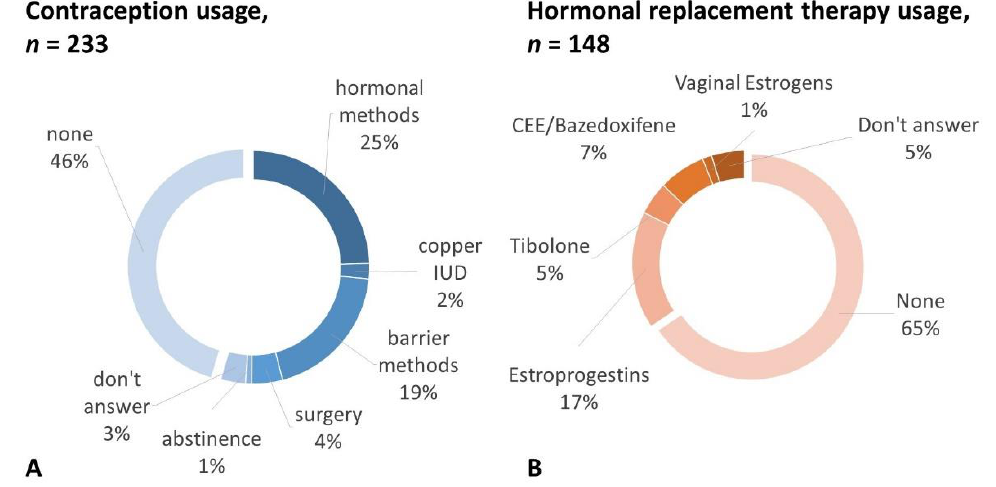
Figure 1. Contraception ( A ) and hormonal replacement therapy ( B ) self-reported use in healthy BRCA 1/2 carriers. IUD = intrauterine device; CEE = conjugated equine estrogens. When asked about the oncological risk related to BRCA1/2 pathogenic variants, 135 (65.5%) women answered that hormonal contraception increases the risk of breast cancer and 23 (11.2%) that it increases the risk of ovarian cancer (Figure 2A).